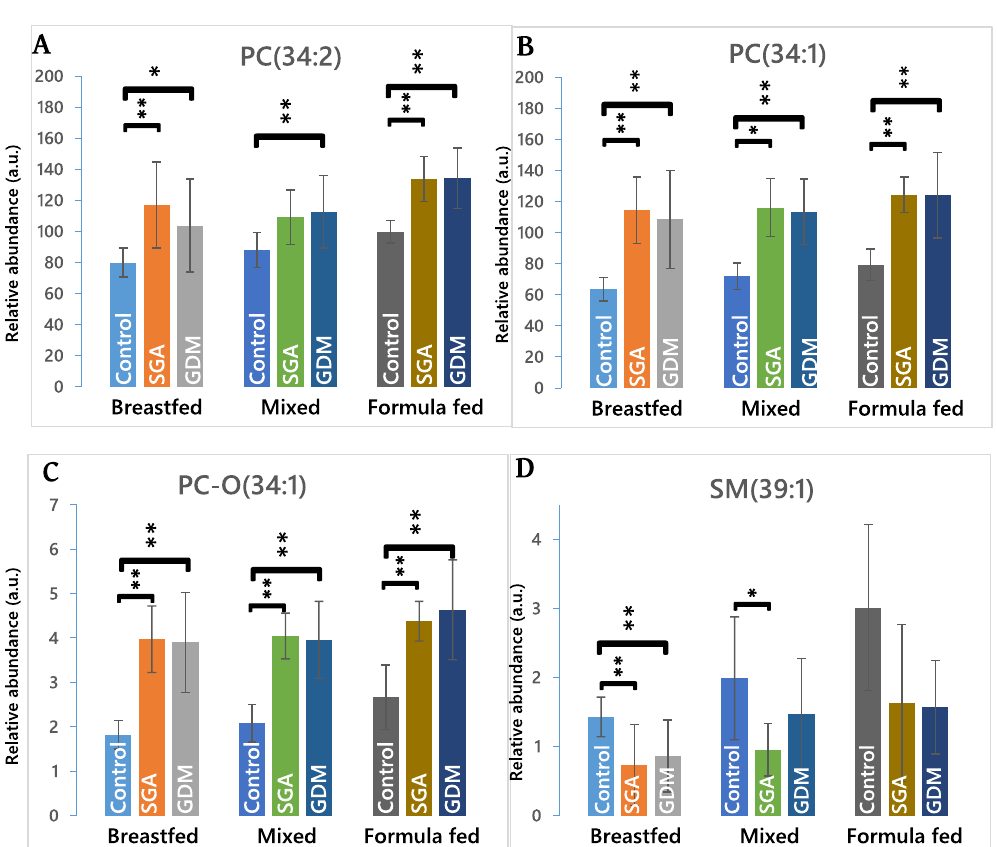
Figure 1. The abundance of candidate biomarkers in infants with normal conditions in utero as well as in SGA and MHG. Only these four lipids passed FDR based on a Bonferroni adjusted significance threshold. Panel ( A ) PC(34:2), isobaric with PE(37:2); ( B ) PC(34:1), isobaric with PE(37:1); ( C ) PC-O(34:1), isobaric with PC-P(34:0); ( D ) SM(39:1). No. variables = 340. p -Values for Bonferroni corrected T-test: for dependent variables = 0·00271 (marked * ) and independent variables = 0·000147 (marked ** )